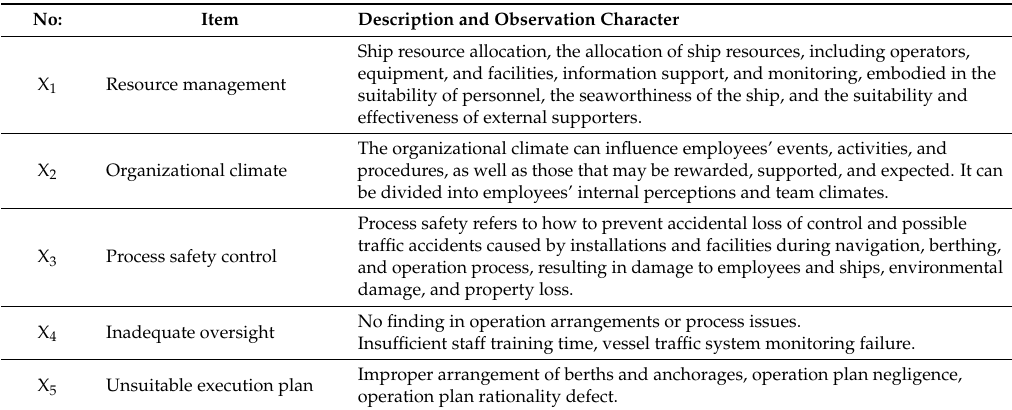
Table 2. Definitions of causal factors of marine accidents.